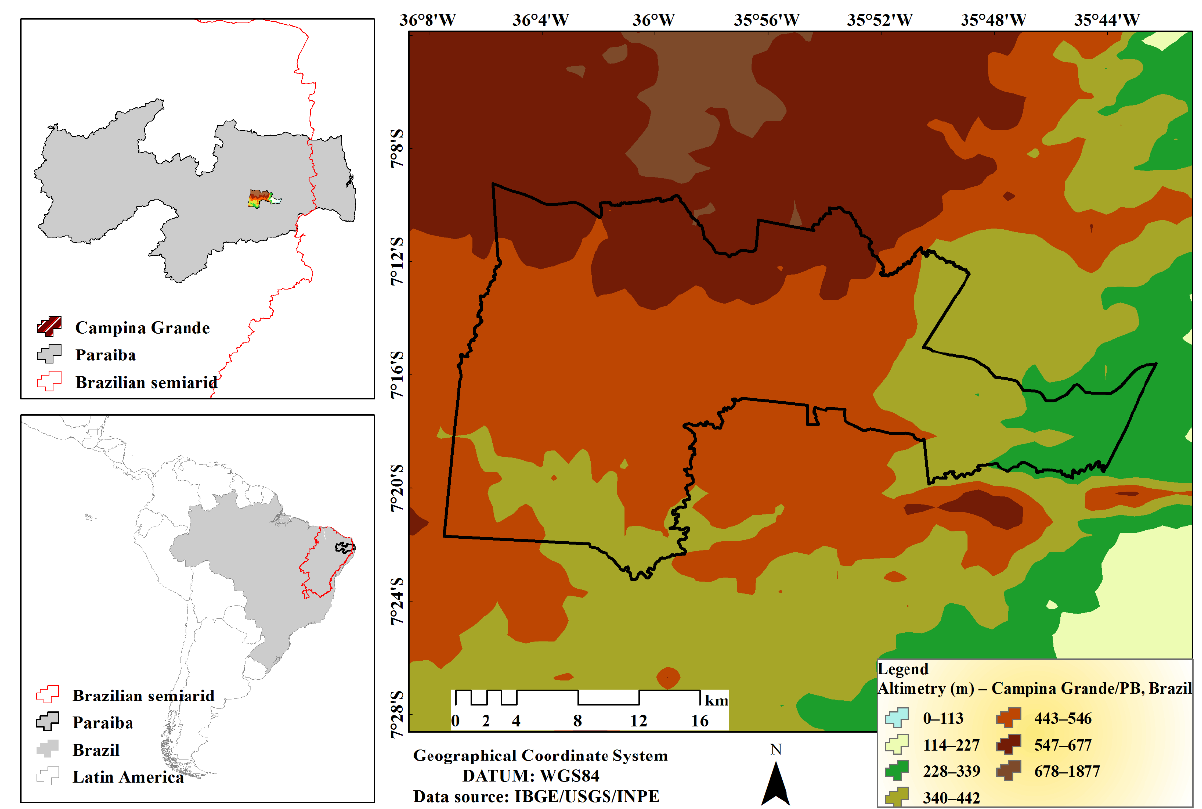
Figure 1. The spatial location of the study area is the municipality of Campina Grande, Paraiba, Brazil. The municipality has an absolute surface of 591,658 km 2 , and an estimated population of 413,830 inhabitants [30]. It is characterized by a predominant vegetation cover of the Caatinga biome and has a tropical climate of altitude with a rainy season starting in